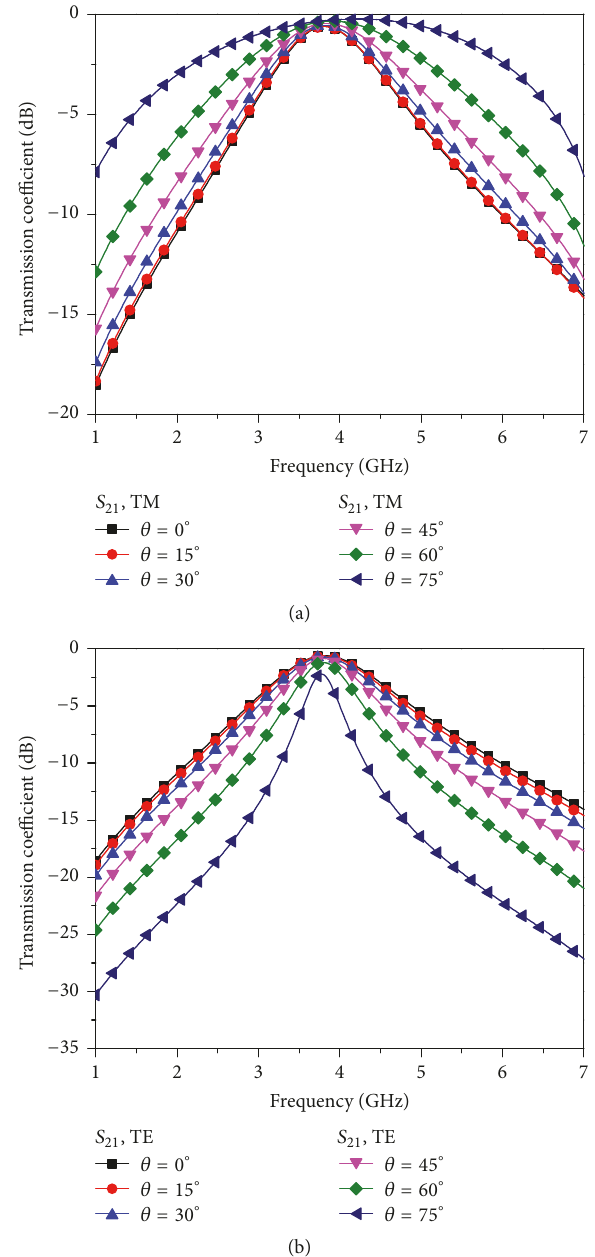
Figure 2: 𝑆 21 characteristics of proposed FSS under different incident angles, (a) TM mode and (b) TE